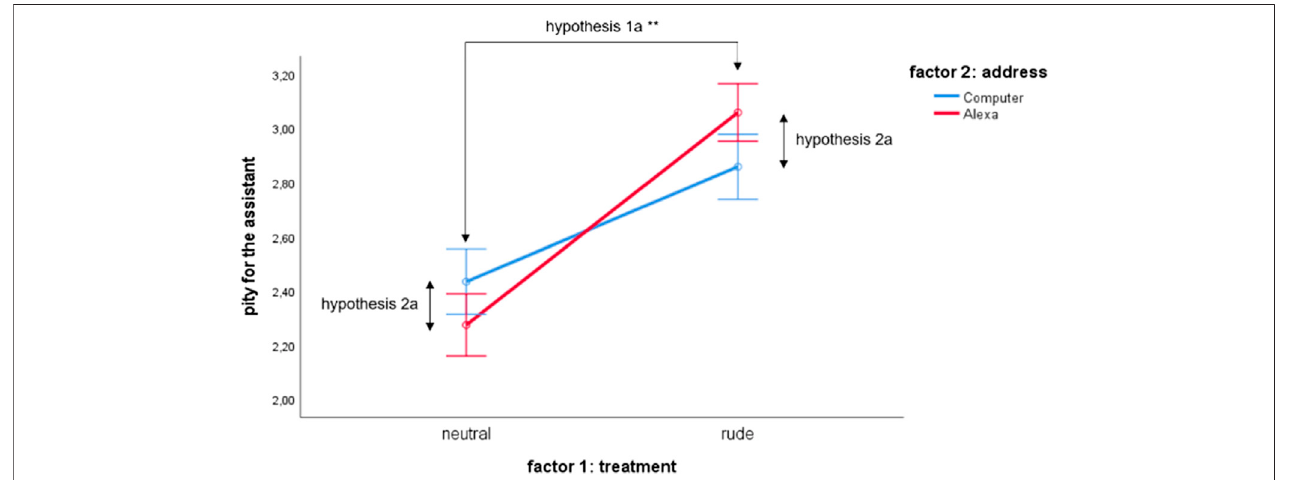
FIGURE 2 | Effects of treatment and form of address on pity for the CA (controlled for trait